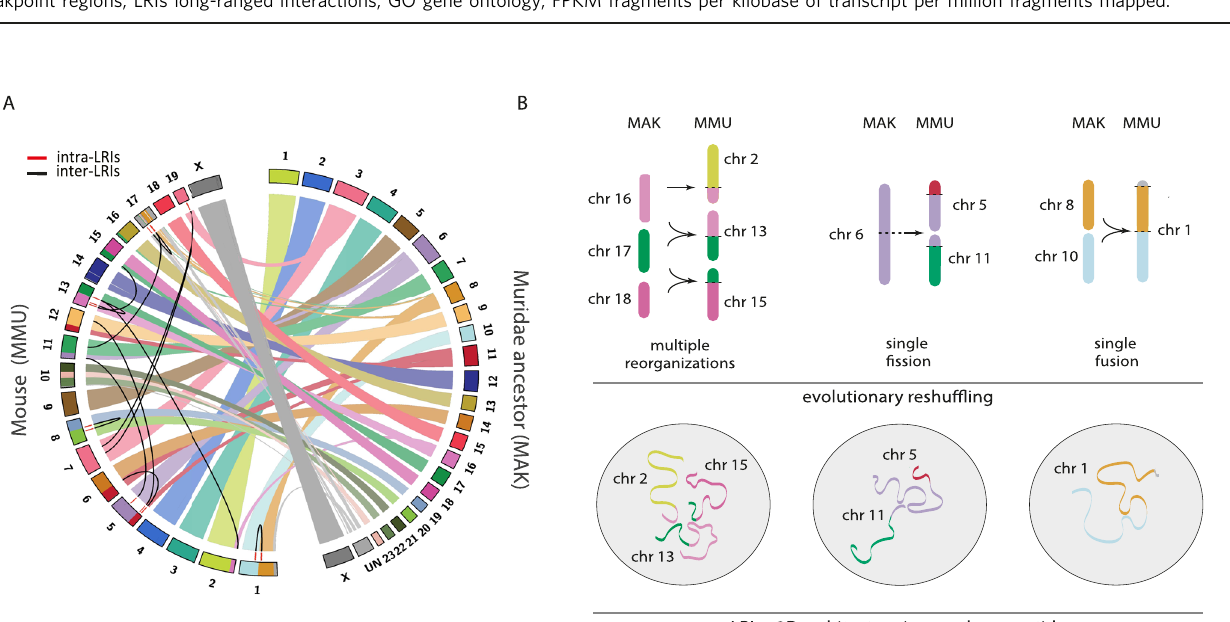
Fig. 4 Long-range interactions in post-meiotic cells. A Iterative correction and eigenvector decomposition (ICE)-corrected Hi-C matrices for chromosome 19 at a 100-kbp resolution for the cell types analysed. Deep blue lines indicate non-mapped bins. Long-rage interactions are highlighted (yellow square) in round spermatids. B Circos plot of the mouse genome depicting the different types of EBRs identi fi ed (Mouse, Muridae, Eumuroidea, Muroidea, Myodonta, Rodentia, Mouse Clade and Mouse Clade + Ctenohystricia speci fi c) and long-rage interactions (LRIs). LRIs containing differentially expressed genes (DEG) are shown in green. C Representative example of intra-chromosomal long-range interactions across a speci fi c region of chromosome 19 (from 14 to 45 Mbp) in mouse round spermatids. Different genomic features are displayed: A/B compartments (in spermatogonia and round spermatids), chromatin states, H3K4me3 peaks, H3K27ac peaks, H3K27me3 peaks, RNA-seq (represented as log FPKM), CTCF peaks and cohesin peaks (REC8 and RAD21L). The genomic locations of EBRs (salmon highlight) and intra-chromosomal long-range interactions (square) are displayed. D Zoom-in of intra-chromosomal long-range interactions detected in chromosome 19, displaying A/B compartments, chromatin states, RNA-seq (represented as log FPKM), and genes from NCBI Ref Seq annotation. Differentially expressed genes (DEG) are shown (red arrow head). E Zoom-in of intra-chromosomal long-range interactions detected in chromosome 7, displaying A/B compartments, chromatin states, RNA-seq (represented as log FPKM), and genes from NCBI Ref Seq annotation. Differentially expressed genes (DEG) are shown (red arrow head). F Gene Ontology Enrichment Analysis (GOEA) of genes found in intra- chromosomal and inter-chromosomal long-range interactions (LRIs) in round spermatids. Only signi fi cant gene ontology (GO) terms with an DAVID enrichment cluster score (ES)> 1.3 are shown, ES is based on a FDR adjusted P value (Fisher ’ s exact test, two-sided). Abbreviations – EBRs evolutionary